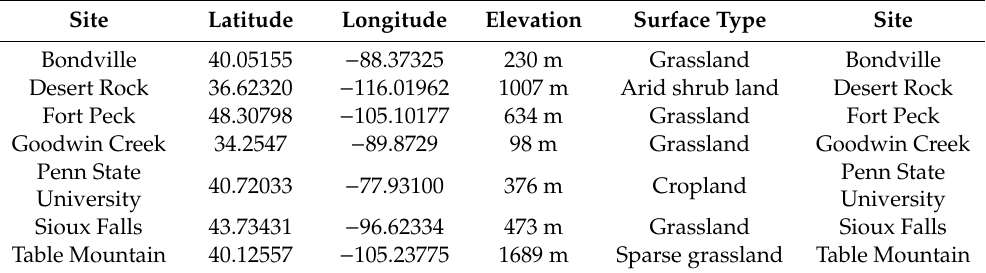
Table 1. Characteristics of the in situ stations of the Surface Radiation (SURFRAD) network.